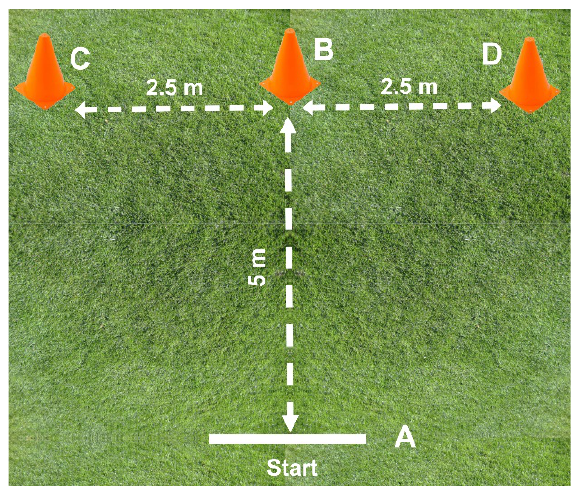
Figure 1. Track for the modified agility t -test. Each player was required to start with both feet behind the starting line (point A) and following the sound signal, he must sprint forward 5-m and touch the cone (point B) with the right hand and then move 2.5-m left to another cone (point C) and touch it with the left hand. Then the player must move in speed to the right up to the cone “D” and touches its base with the right hand, and shuffle back to cone “B” with the left hand, after which the athlete runs backwards for 5-m to the finish line (point A). Agility times (s) were rec- orded using timing gates (Microgate, Bolzano, Italy). Each player performed 3 trials, with the best time used for subsequent analysis.